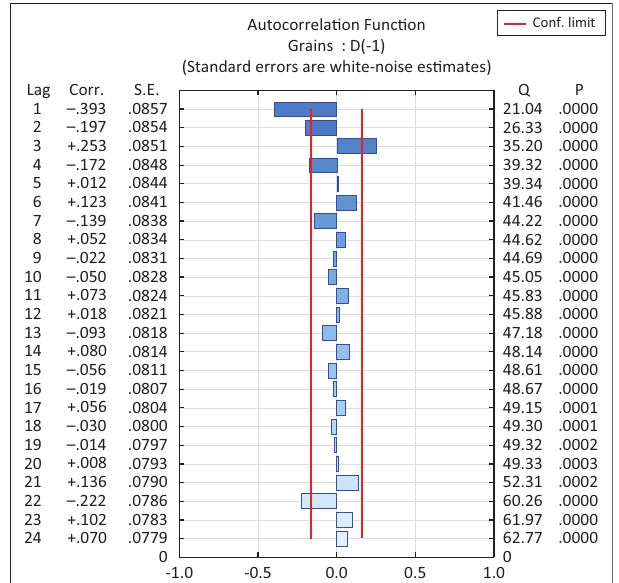
FIGURE 4: Autocorrelation function for grains.